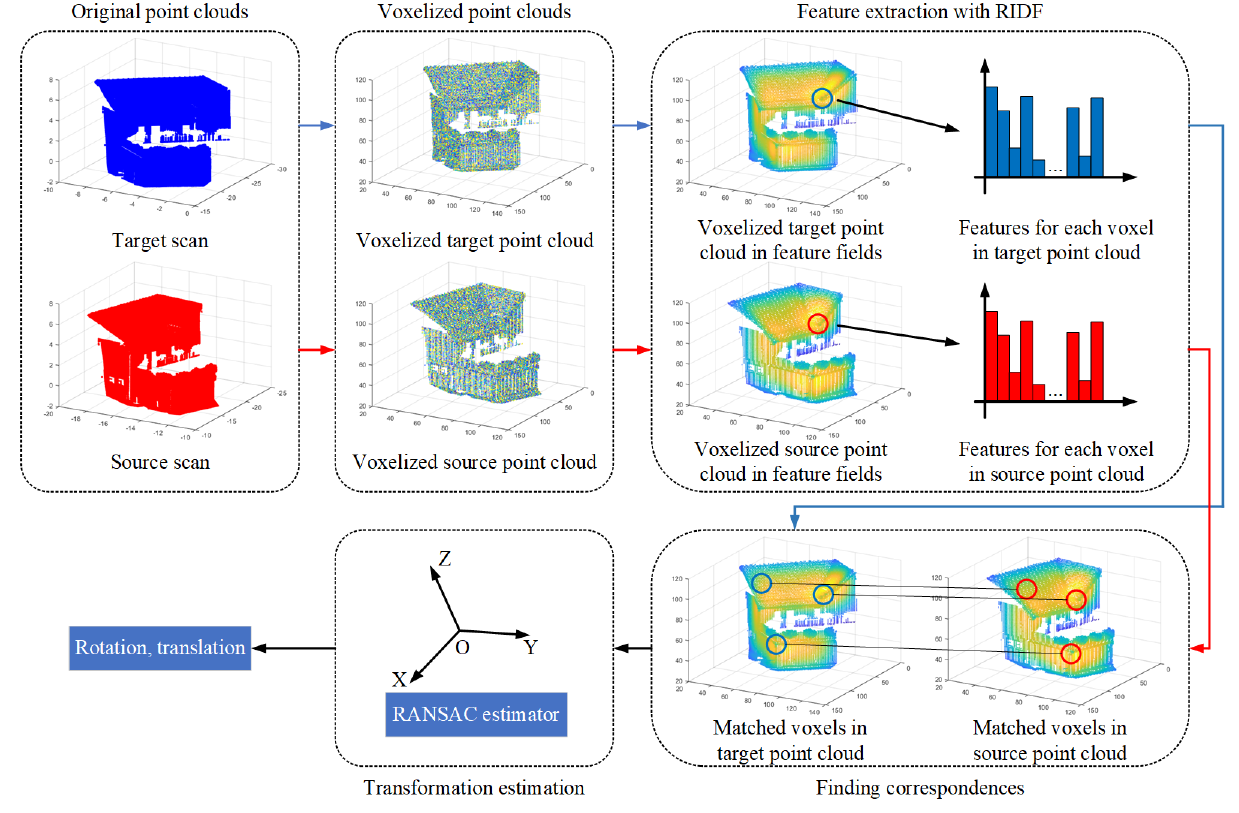
Figure 1. Workflow of the proposed coarse registration strategy.